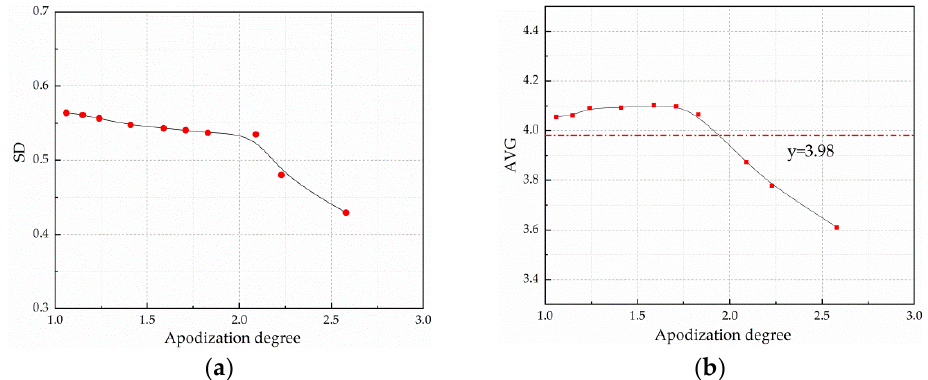
Figure 11. ( a ) The precision of C 2 H 4 concentration inversion; ( b ) the AVG of C 2 H 4 concentration inversion.